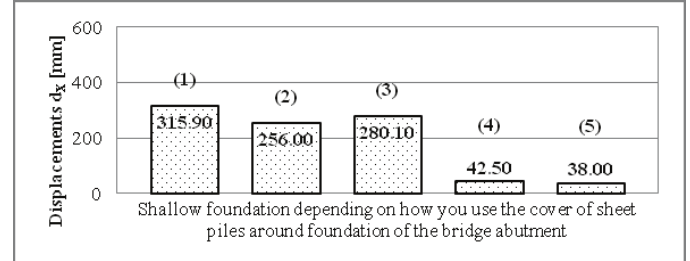
Fig. 8d. Displacements d x (mm) depending on the use of sheet piles as a cover of the foundation. The most unfavorable combination of load